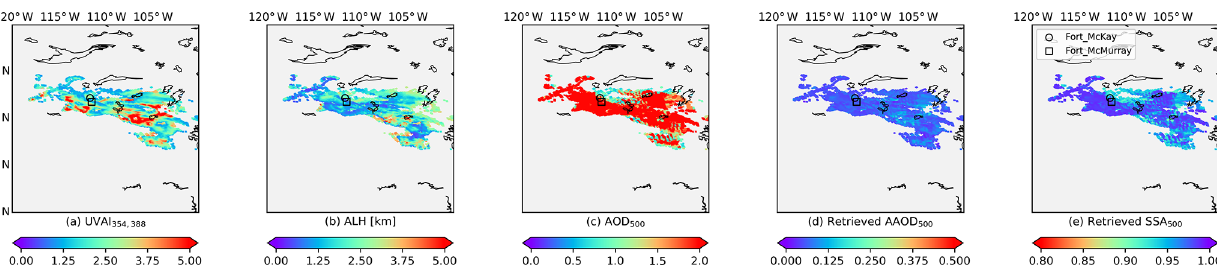
Figure 14. SVR retrievals for the Canadian fire event on 29 May 2019: (a) TROPOMI UVAI calculated by reflectance at 354 and 388nm; (b) TROPOMI ALH; (c) MODIS AOD at 550nm; (d) retrieved AAOD at 500nm; (e) retrieved SSA at 500nm.